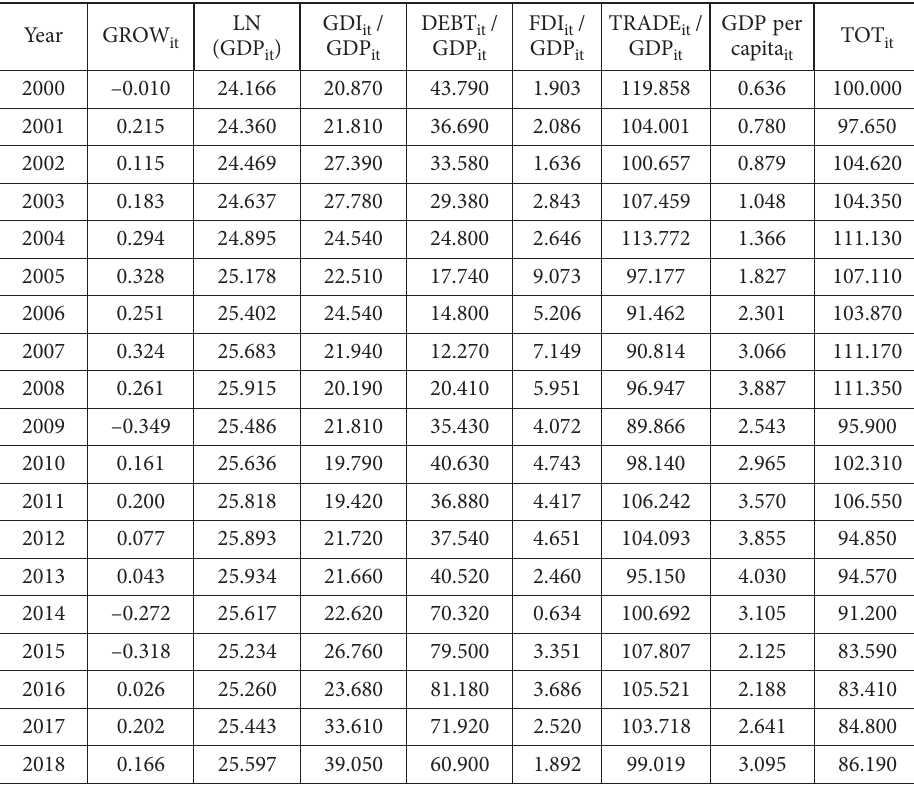
Table A1. Basic input data for the model (3), (4) (source: elaborated based on World Trade Organiza- tion, n.d.; World Bank, n.d.; Ukraine National Debt, 2020; The Global Economy, 2020)